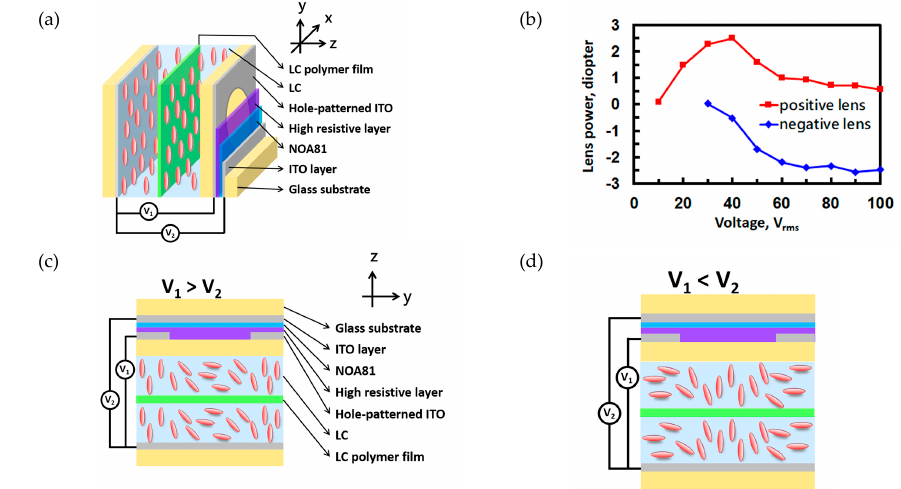
Figure 20. ( a ) Structure of LC lens. ( b ) Voltage-dependent lens power. Red squares denote the lens power at di ff erent V 1 for V 2 = 10 V rms and f = 4.2 kHz. Blue diamonds represent the lens power vs. di ff erent V 2 when V 1 = 30 V rms and f = 800 Hz. The LC lens is ( c ) positive when V 1 > V 2 and (d) negative when V 2 > V 1